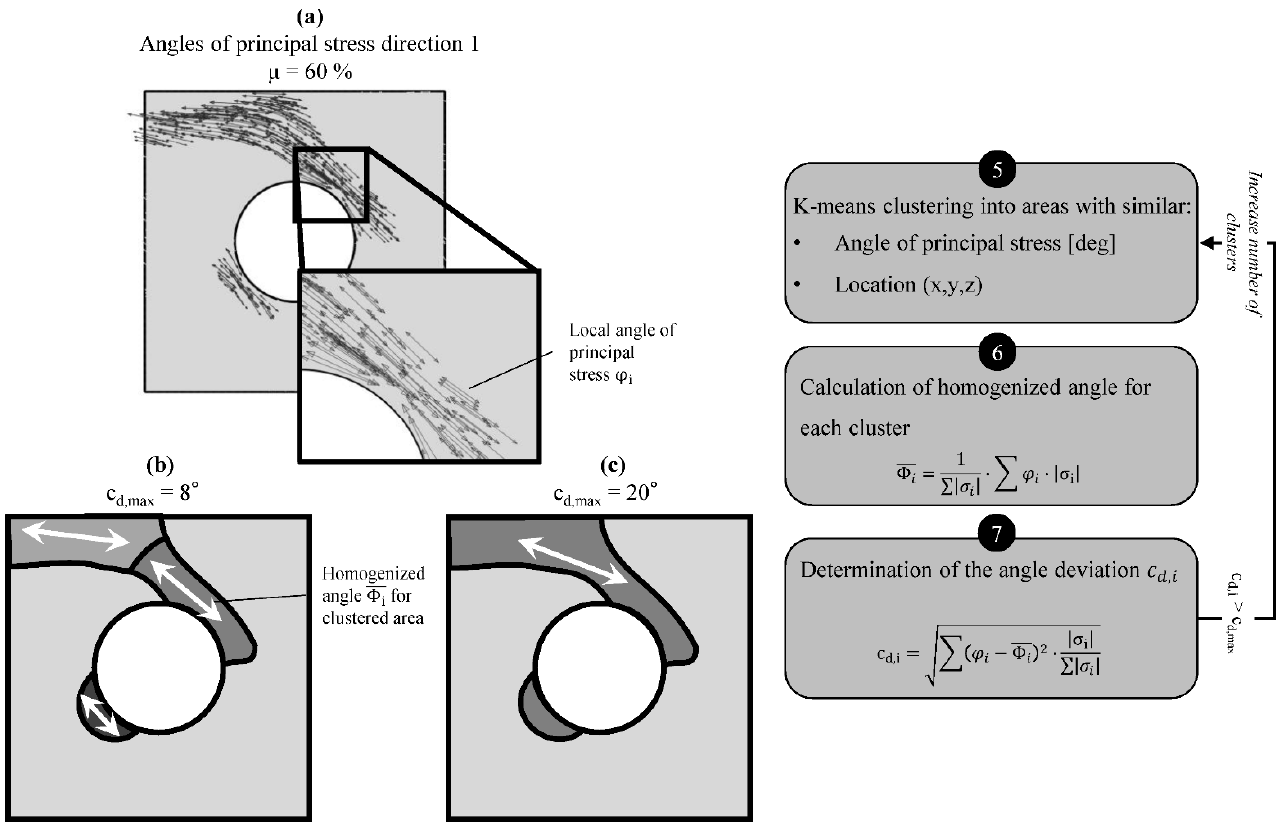
Figure 5. Clustering of reinforcement area into multiple areas with similar angles of principal stresses using deviation factor c d,max . ( a ) Shows the resulting principal stress directions for μ = 60%. In ( b , c ) the calculated cluster angles are shown for c d,max = 8° and 20°. For c d,max = 8° three clusters are required, for c d,max = 20° only one cluster is required.